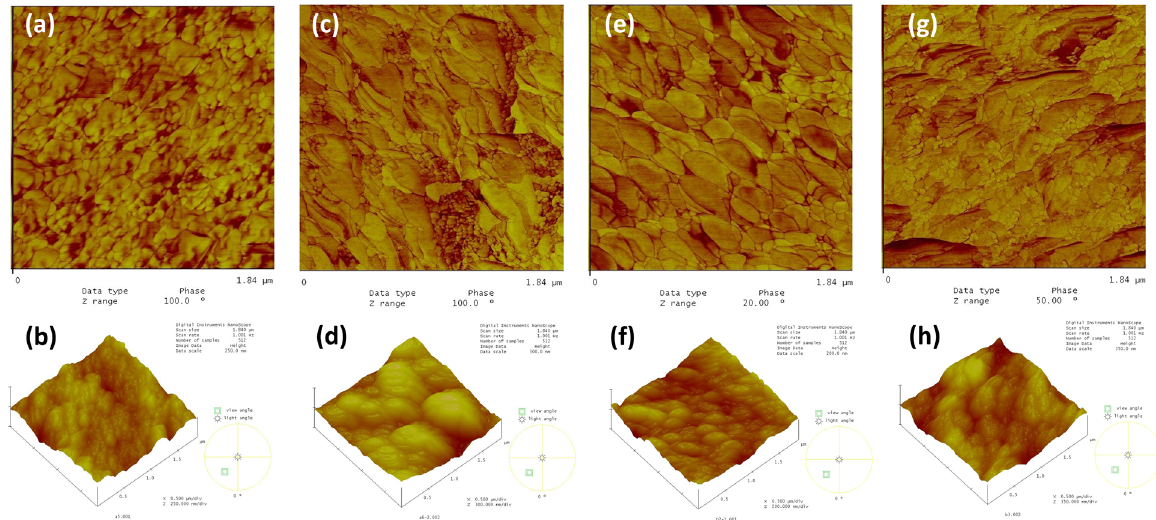
Fig. 9 The AFM images of adsorbed BSA on ( a ) the glass/ fi broin/c- HAp; phase image, ( b ) the glass/ fi broin/c-HAp; 3-dim. topographical image, ( c ) the glass/ fi broin/m-HAp; phase image, ( d ) the glass/ fi broin/ m-HAp; 3-dim. topographical image, ( e ) the glass/sericin/c-HAp;